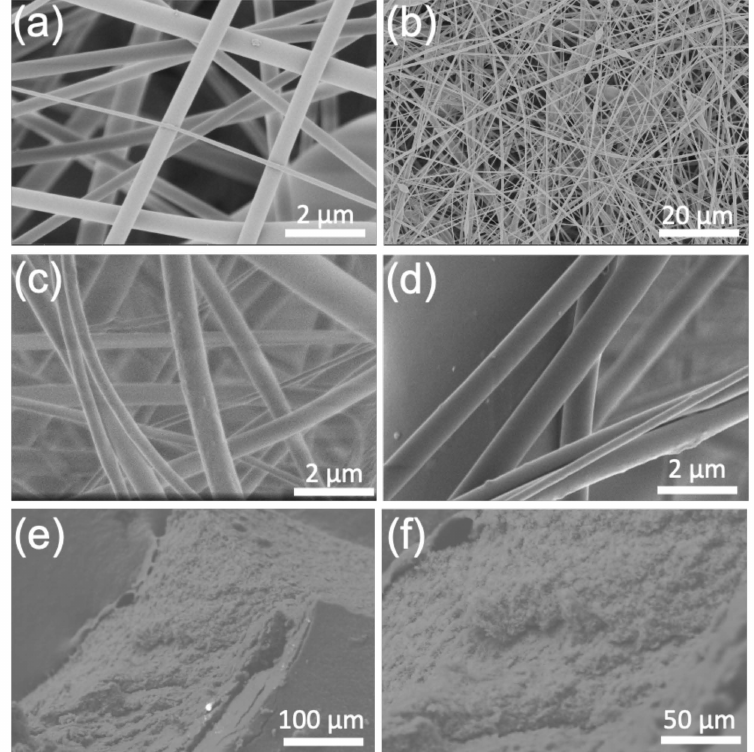
Figure 4. ( a , b ) SEM micrographs of unmodified CANFs (blank), ( c ) CANFs loaded with 5 wt. % Ib ( d ) CANFs loaded with 10 wt.% Ib, ( e ) 5 wt.% Ib-loaded CANFs coated with poly-AAm, and ( f ) 10 wt.% Ib-loaded CANFs coated with